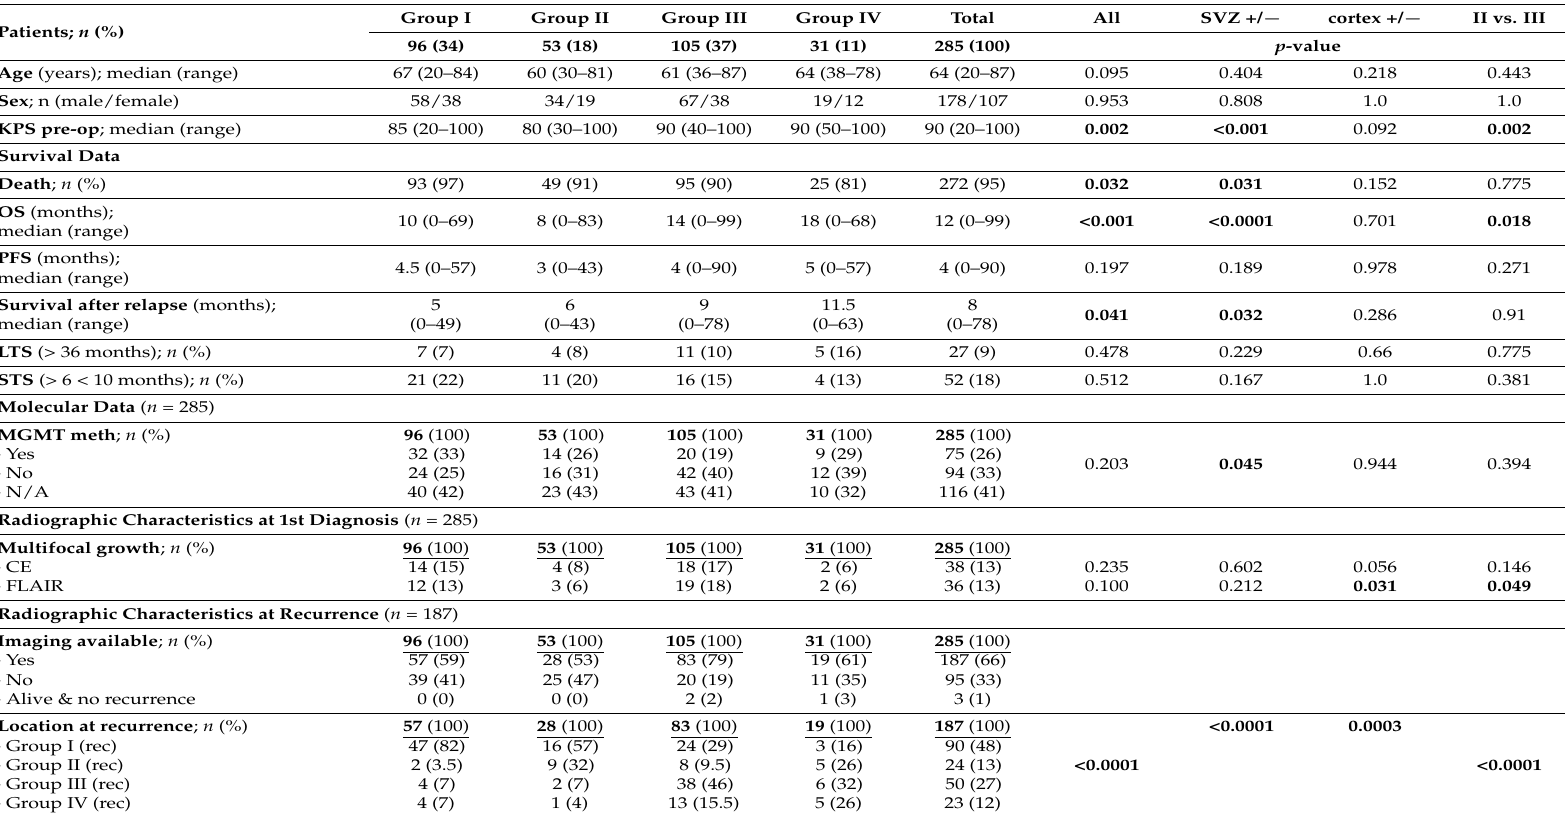
Table 1. Patient Characteristics of the IDH1-Wildtype